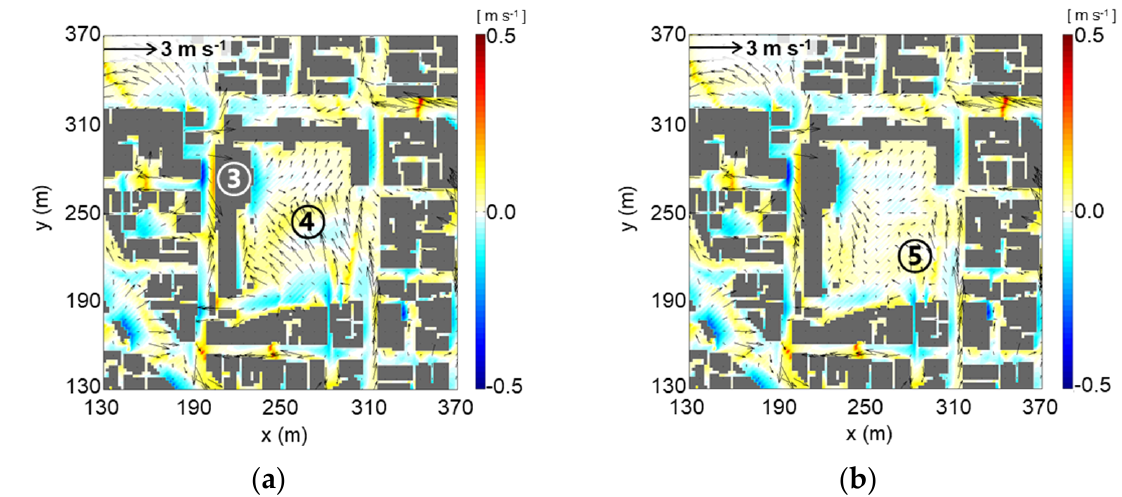
Figure 10. Wind vectors and shading of the vertical velocity distribution at 1 m above the ground for the east–northeasterly inflow in ( a ) the CNTL case, and ( b ) the T4M case.